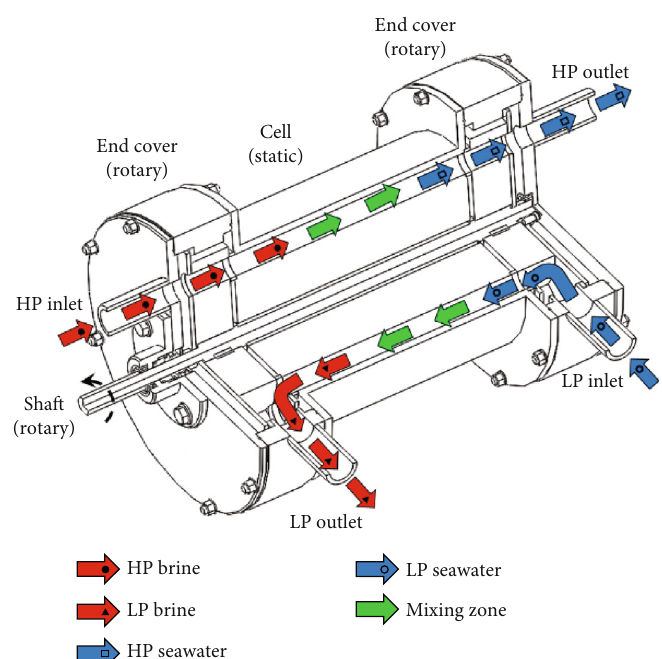
Figure 2: Flow schematic of V-RERD